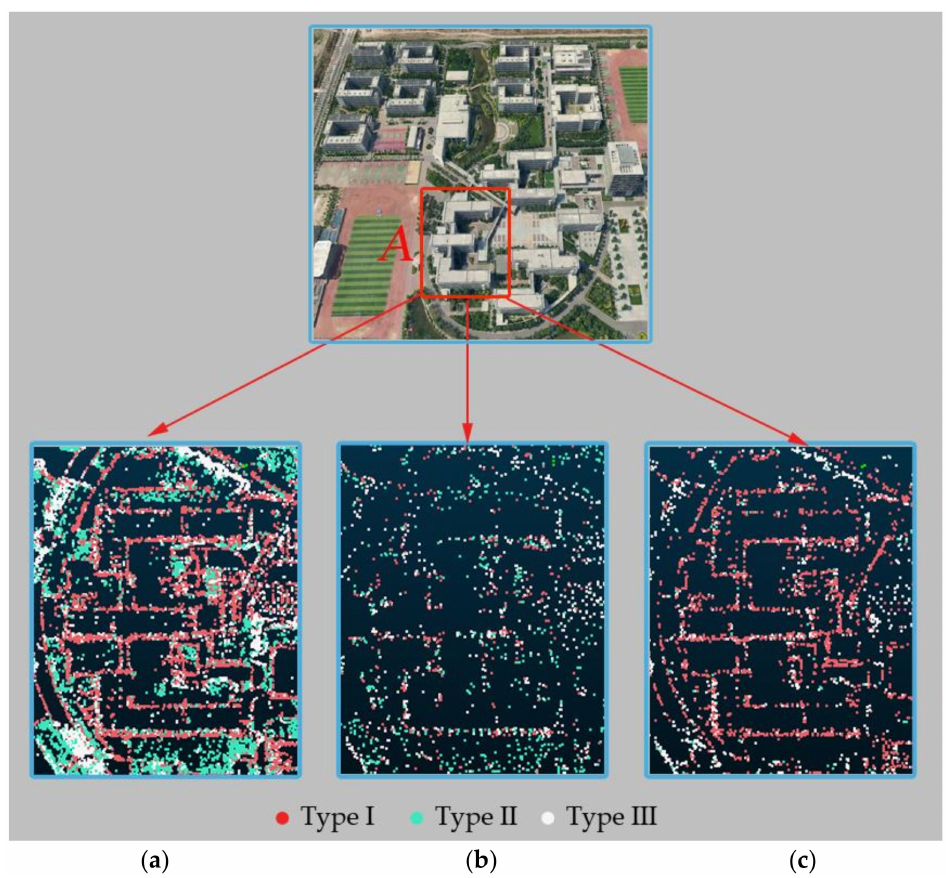
Figure 9. Sparse point cloud of the building area (rectangle A) in an oblique image. ( a ) The result of the original SIFT algorithm, ( b ) the result of Wu method and ( c ) the result of the proposed